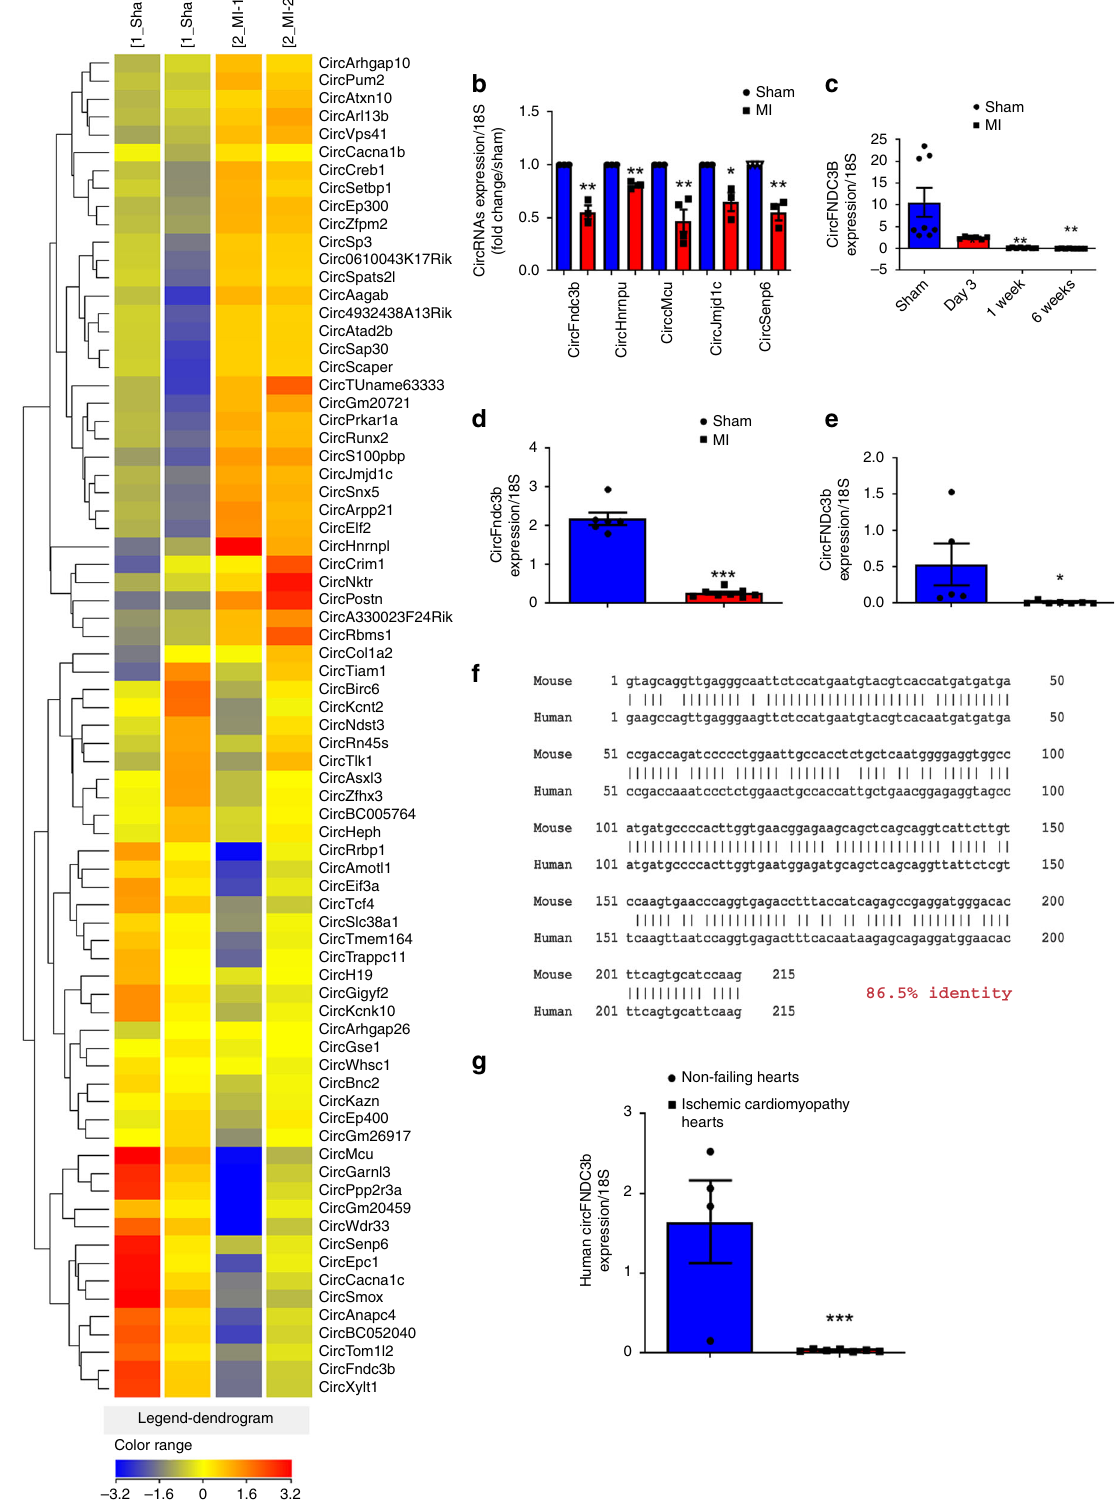
CircFndc3b overexpression attenuates LV dysfunction post-MI in mice . Reduced circFndc3b levels in mouse hearts post-MI (Fig. 1c) and in failing ischemic human hearts (Fig. 1g) suggested a possible physiological role for circFndc3b in